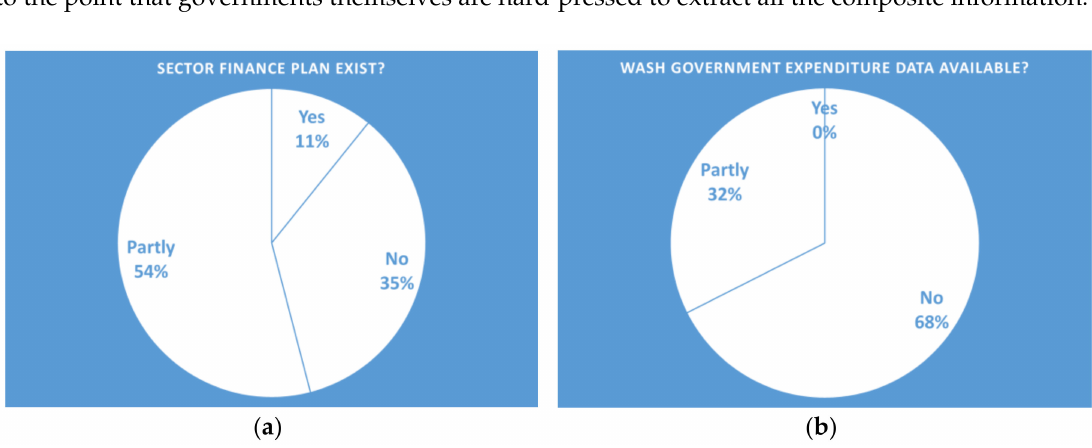
Figure 1. ( a ) Water, sanitation and hygiene (WASH) sector finance plans; ( b ) WASH expenditure data